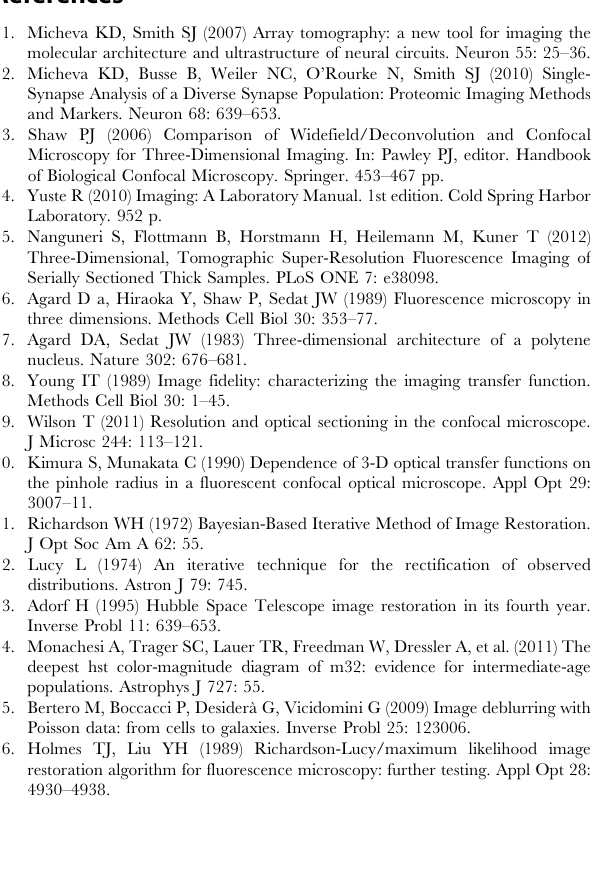
non-deconvolved point sources are resolvable. Thus, deconvolu- tion decreases the threshold of resolvability for 4 pixel shift to 2 pixel shift. Figure S2 Fourier Transforms of ATW, ATD and SIM Image Volumes. (A–C) Representative max projection images of ATW, ATD and SIM image volumes (ten 70 nm sections: above) presented with the Fourier Transforms (FT) of the Image Volumes as performed in FIJI (below). The false colored FT images represent the spatial frequency information present in the image, and the magnitude of the frequency component in the image is represented by intensity in the image. The center of the image is the mean frequency component of the image, and as we move further from the center of the image the intensities represent the magnitude of higher and higher spatial frequencies present in